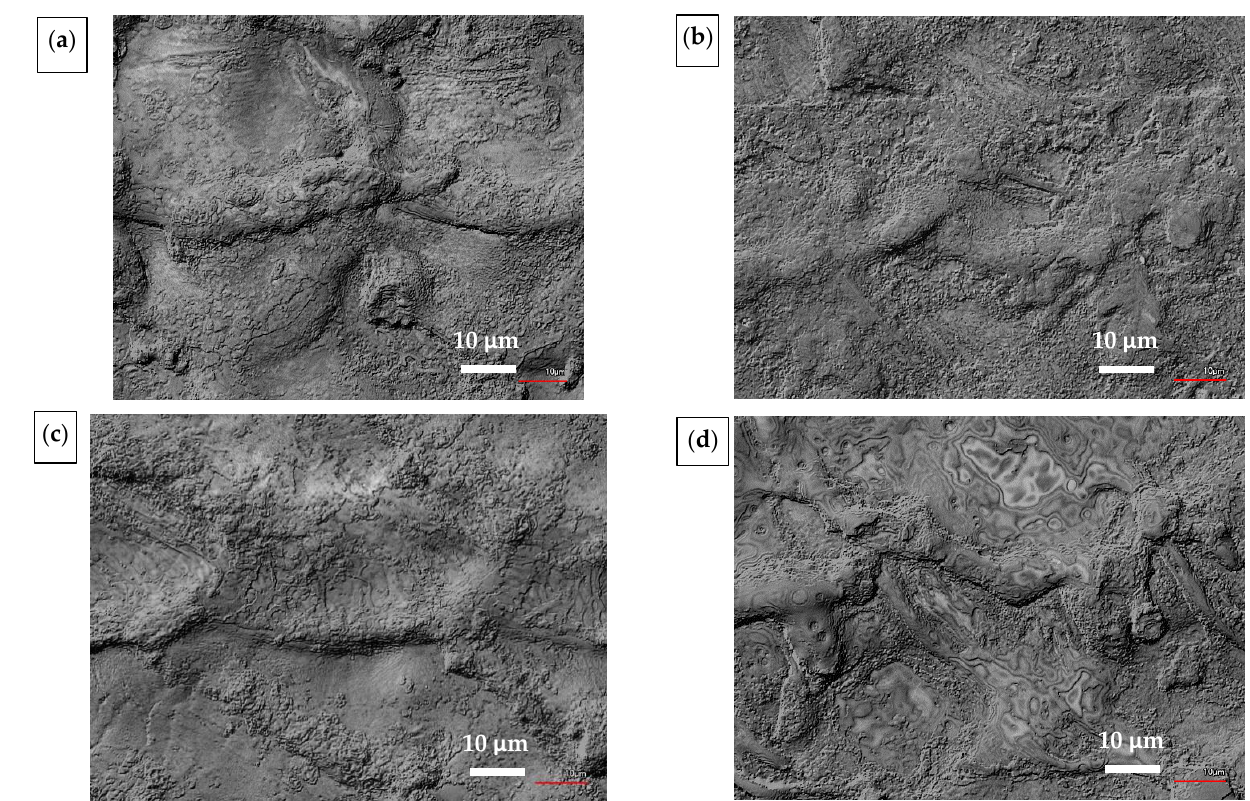
Figure 6. SEM images of stripped samples: ( a ) AlTiN1; ( b ) AlTiN2; ( c ) AlTiN3; ( d ) AlTiN4. Table 7. Amounts of elements on the surface after laser stripping of the AlTiN coating. Part of a